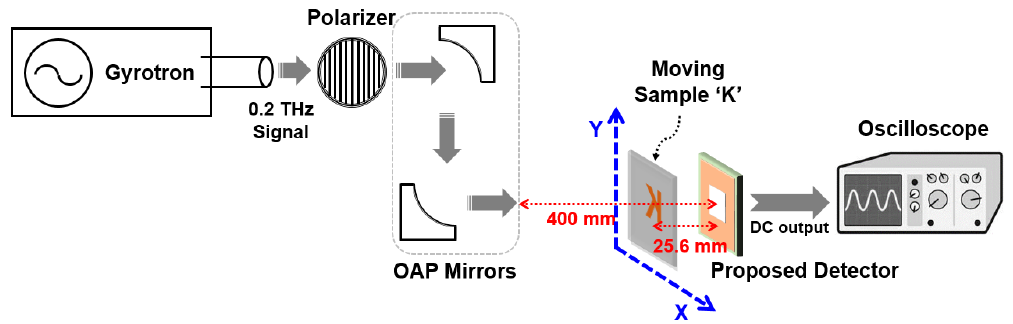
Figure 10. Measurement setup of THz imaging using the detector.